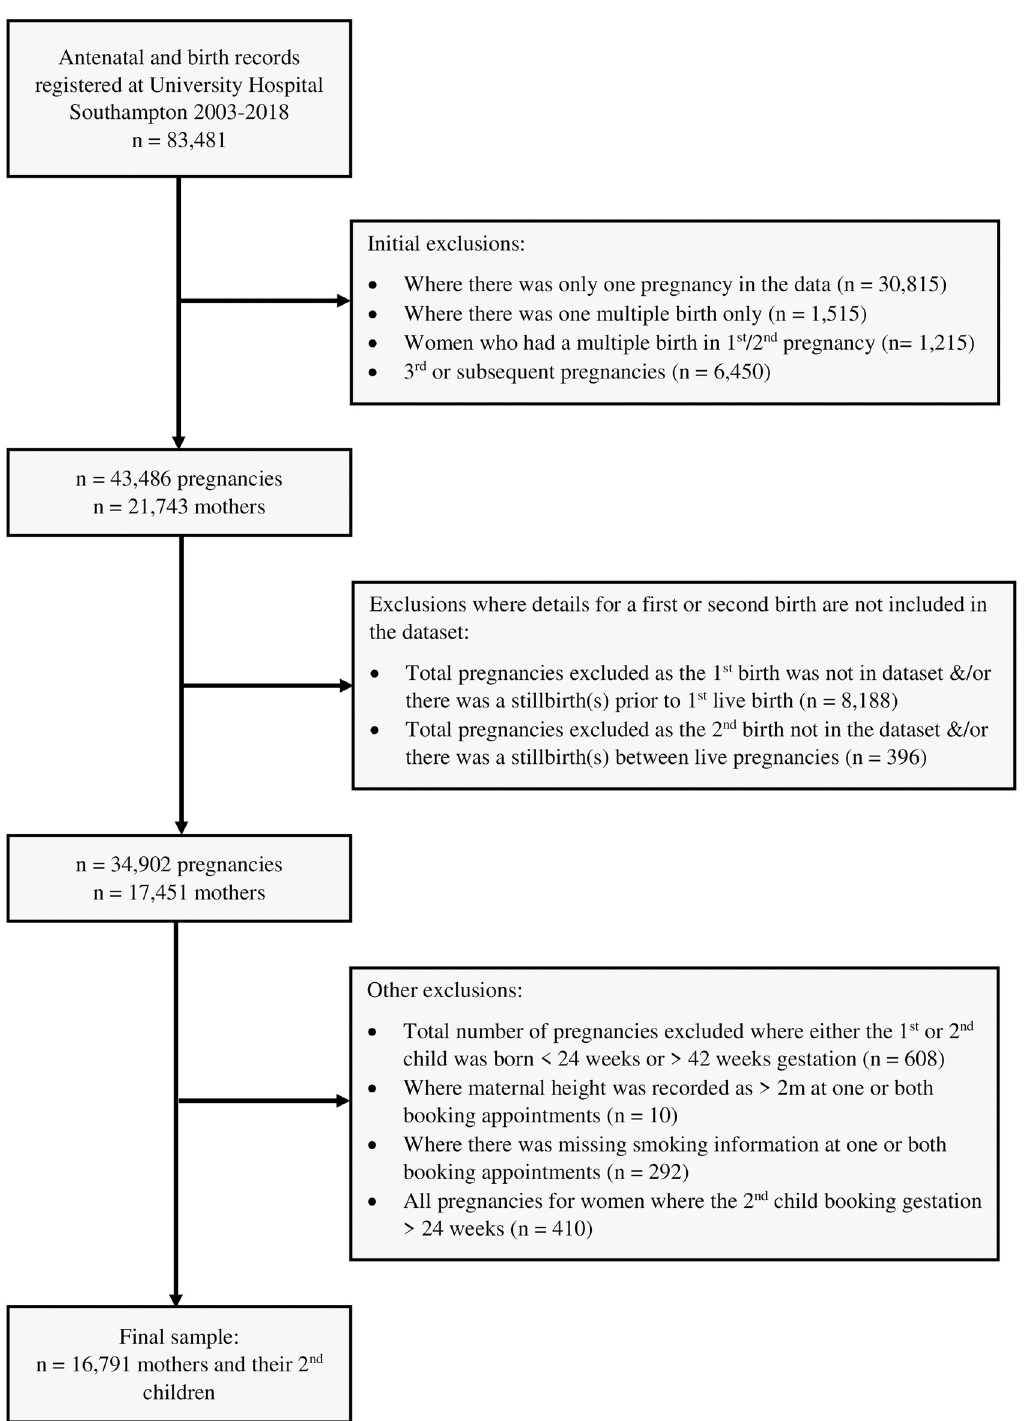
Fig 1. Flow diagram showing the composition of the final data used in this analysis. Exclusions from the data are detailed in Fig 1. Births which took place before 24 weeks or after 42 weeks gestation were excluded as SGA reference values do not exist for these gestations. An exclusion for pregnancies where the first ANA for the second pregnancy took place after 168 days gestation (as assessed by ultrasound examination performed by healthcare professionals) was made since these were likely to be high-risk pregnancies referred from elsewhere. Variables documenting the previous numbers of live and stillbirths were used to identify women giving birth for the first and second time and to exclude women who either had a first or second birth elsewhere or who had a stillbirth prior to their first live birth or between live births.